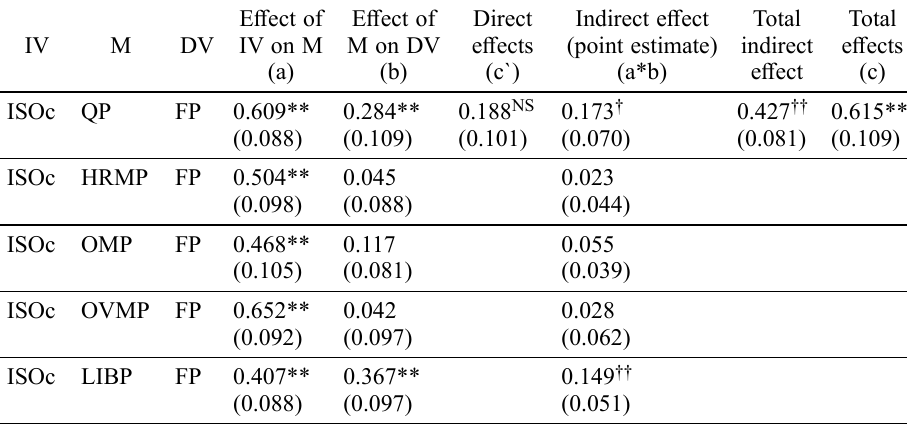
Table 7. Mediation of the effects of ISO Certification on company’s financial performance through company’s internal and external benefits (standard errors in parentheses, 5000 bootstrap